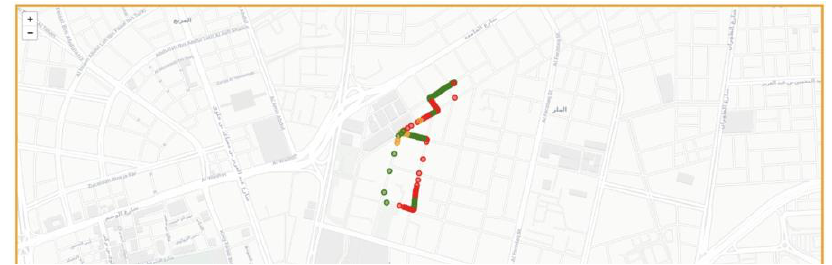
Figure 4. List of recordings from the web interface of the App.